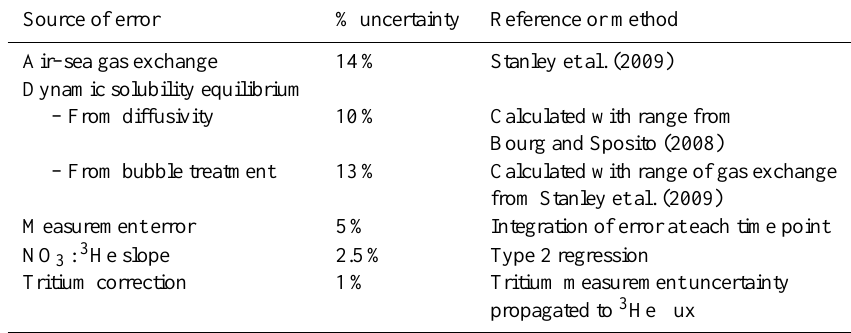
Table 2. The fractional uncertainty caused by different sources in the calculations of nitrate flux for the 2003–2006 time